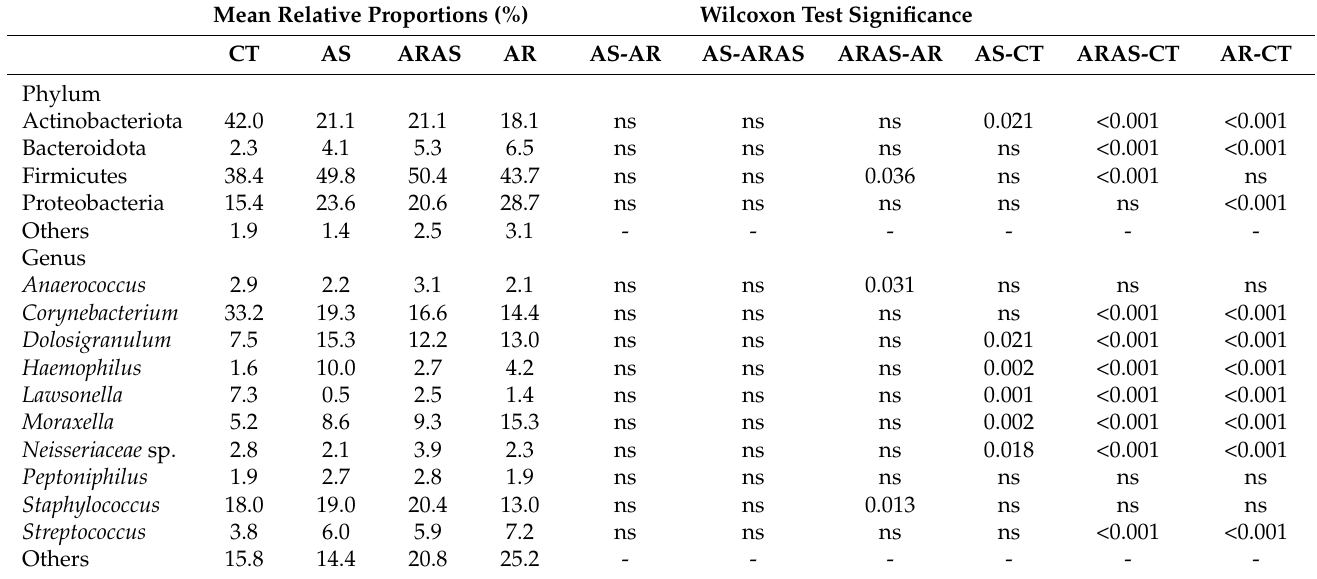
Figure 1. Bar plots of mean relative proportions of the top bacterial phyla and genera in the nasal bacteriome of participants with asthma (AS), allergic rhinitis with comorbid asthma (ARAS), allergic rhinitis (AR) and healthy controls (CT). Table 1. Mean relative proportions and statistical significance of pairwise comparisons (Wilcoxon test) of bacterial genera and phyla in the nasal microbiome of participants with asthma (AS), allergic rhinitis with comorbid asthma (ARAS), allergic rhinitis (AR) and healthy controls (CT). ns = not